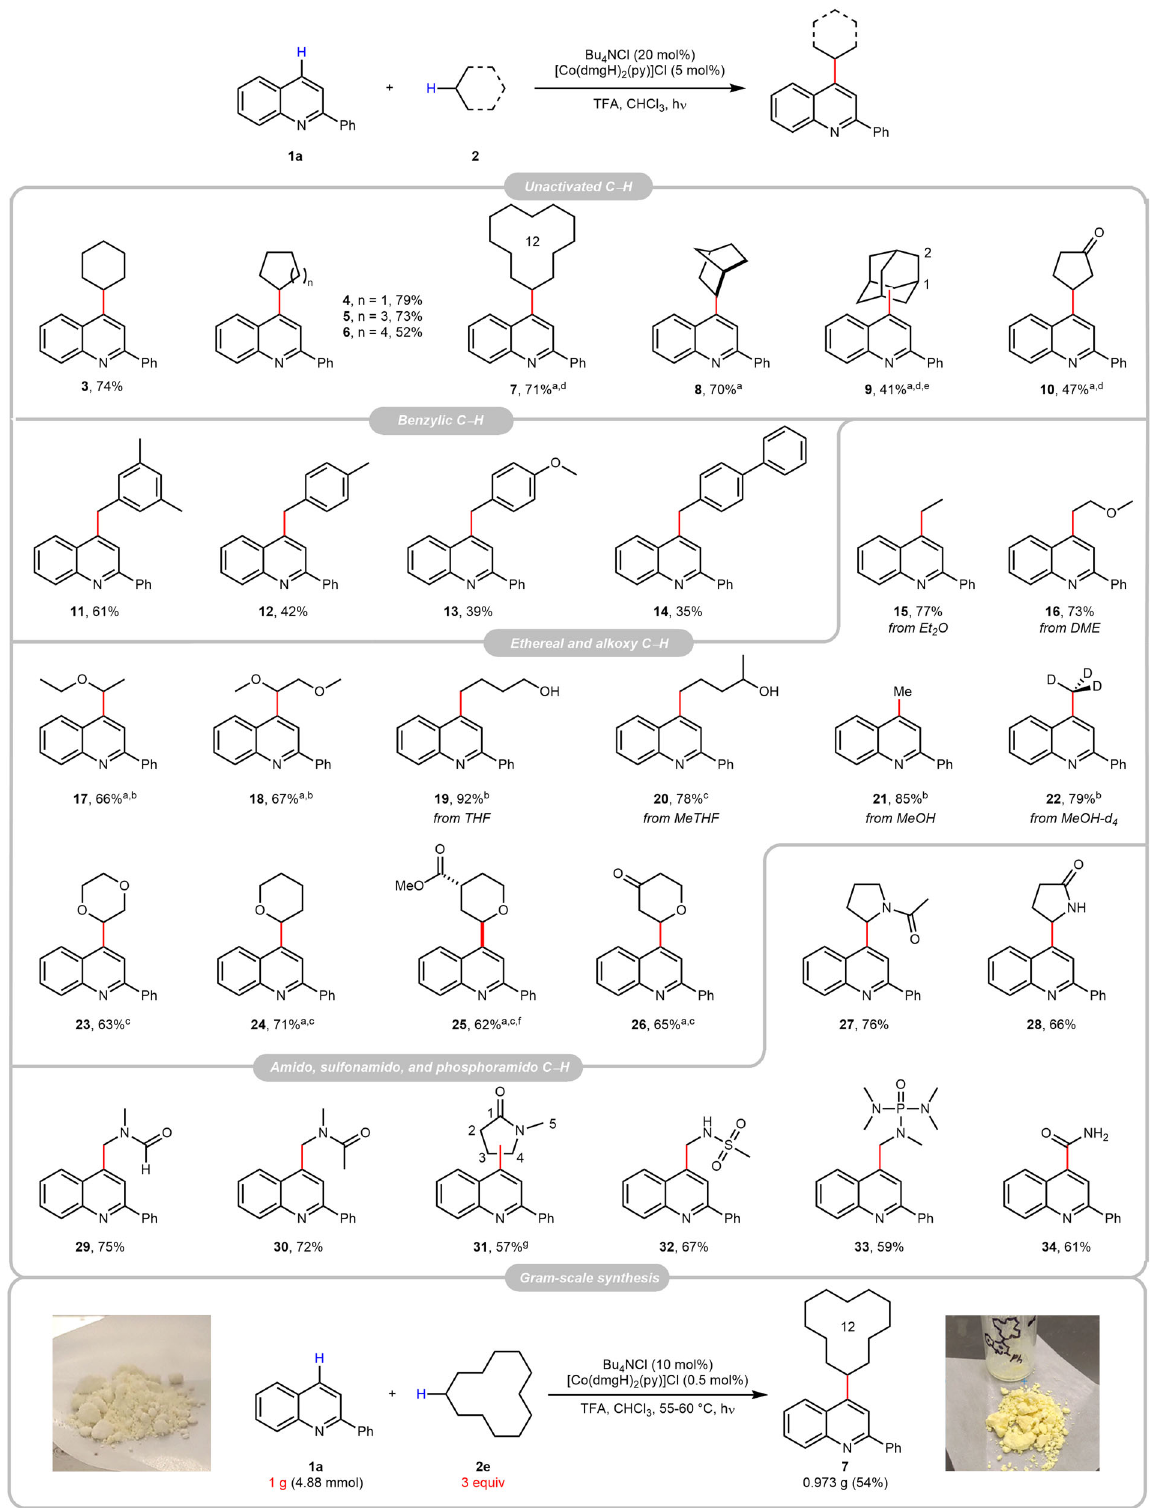
Fig. 2 Substrate scope of alkane. Reaction conditions: 1a (0.2 mmol), 2 (0.6 mL for liquid, or 10 equiv. for solid), Bu 4 NCl (0.04 mmol), [Co(dmgH) 2 (py)]Cl (0.01 mmol), and TFA (0.6 mmol) in CHCl 3 (1.5 mL) under light irradiated at 20 – 25 °C for 20 h under N 2 , unless otherwise speci fi ed, and the yields were isolated ones. Reaction conditions for the gram-scale synthesis: 1a (4.88 mmol), 2e (14.6 mmol), Bu 4 NCl (0.49 mmol), [Co(dmgH) 2 (py)]Cl (0.025 mmol), and TFA (14.6 mmol) in CHCl 3 (8 mL) under light irradiated at 55 – 60 °C for 72 h under N 2. a The reaction was run for 36 h. b 1.2 equiv. of TFA was used. c 2 equiv. of TFA was used. d The reaction was heated to 55 – 60 °C. e A mixture of congeners, C1:C2 = 1:0.9. f A mixture of trans isomers. g A mixture of congeners, C4:C5 = 1:0.26; dmg dimethylglyoxime, TFA tri fl uoroacetic acid, THF tetrahydrofuran, MeTHF 2-methyltetrahydrofuran, DME 1,2-